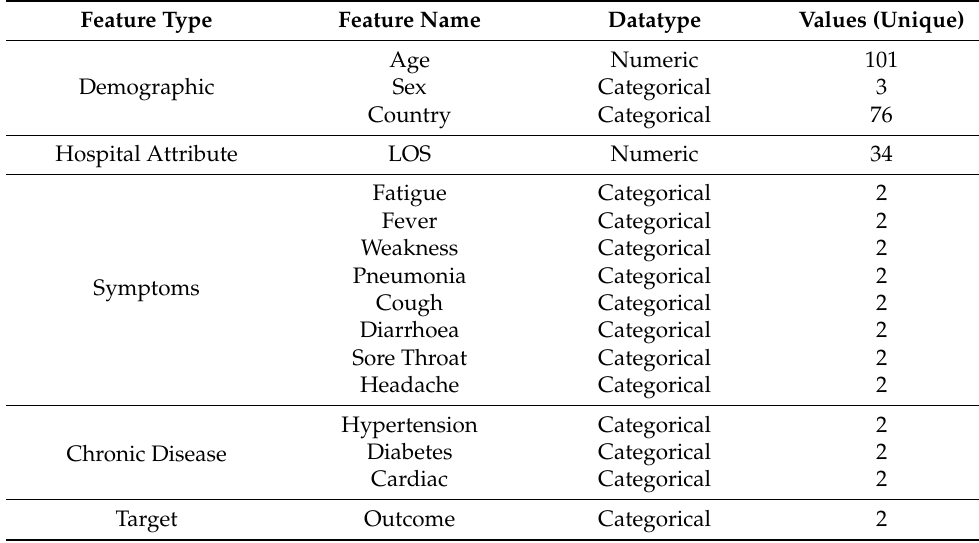
Table 3. Description of the